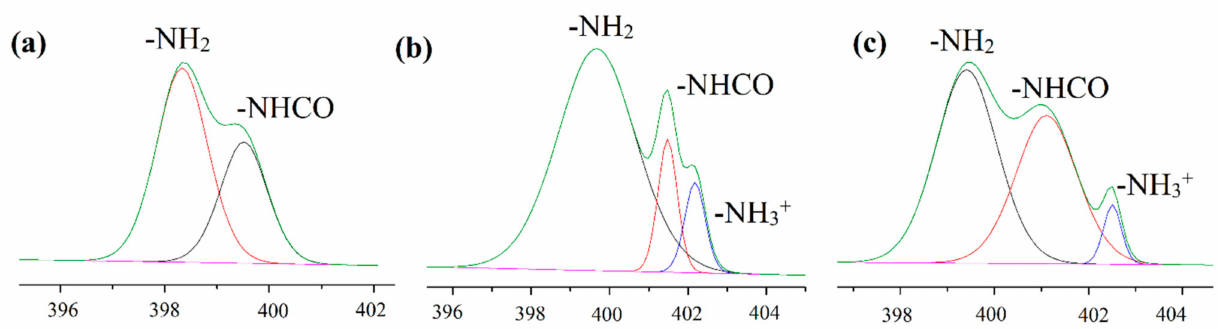
Figure 5. XPS N1s spectra of ( a ) RF, ( b ) g -CS, ( c ) g -CS-ChS. The green line corresponds to the envelope/fitting curve, and the colored curves to the deconvoluted